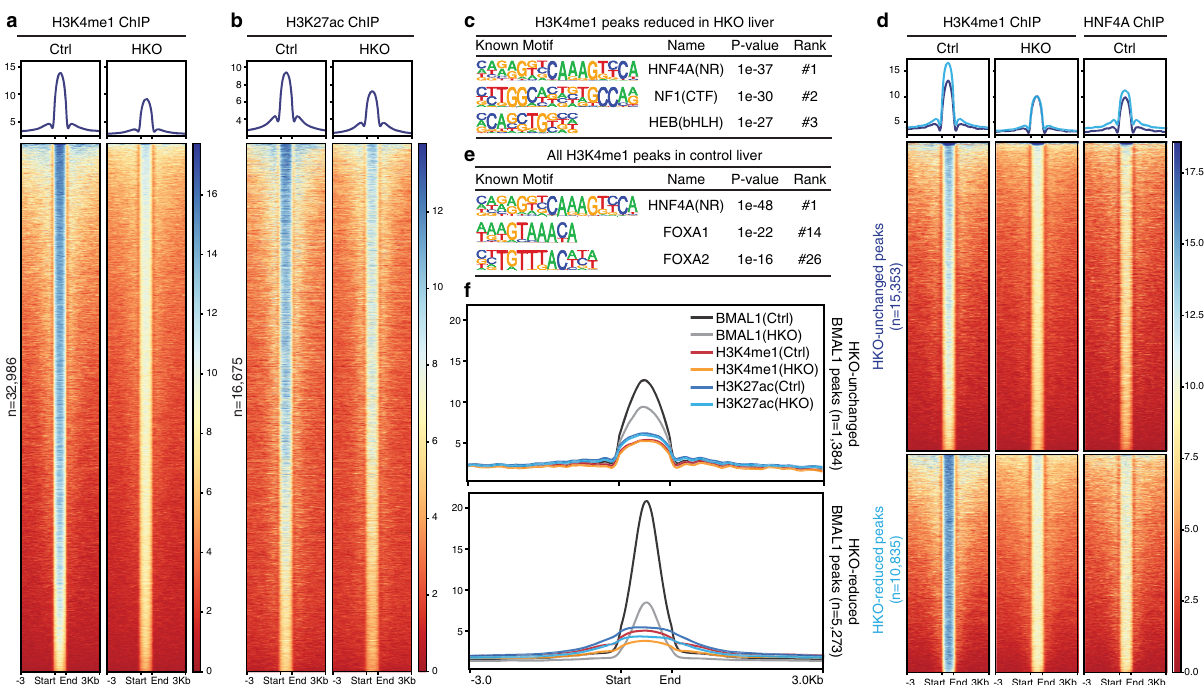
Fig. 2 Hnf4a knockout alters the genome-wide epigenetic landscape. a , b Heatmap of H3K4me1 ( a ) or H3K27ac ( b ) ChIP-seq signals at ZT6 in control (left) or HKO (right) liver centered at all peaks in control liver. Peaks are ordered vertically by signal strength. c Motif analysis of HKO-deprived H3K4me1 sites. Known consensus motifs are shown with corresponding enrichment signi fi cance values. d H3K4me1 peaks in control and HKO livers were partitioned into three categories with DiffBind (the HKO-enriched group has only 23 peaks and could not be plotted), and then the corresponding HNF4A occupancy (at ZT16) at each H3K4me1 site was plotted. Each horizontal line represents a single H3K4me1 site. Peaks were ordered vertically by the strength of the H3K4me1 ChIP signal in control liver. e Motif analysis of all H3K4me1 marked sites in the control liver. Known consensus motifs are shown with corresponding enrichment signi fi cance values. f Metaplot showing the average intensity of BMAL1, H3K4me1, and H3K27ac ChIP-seq signals (all at ZT6) in control or HKO livers surrounding HKO-unchanged (upper panel) or HKO-reduced (lower panel) BMAL1 peak